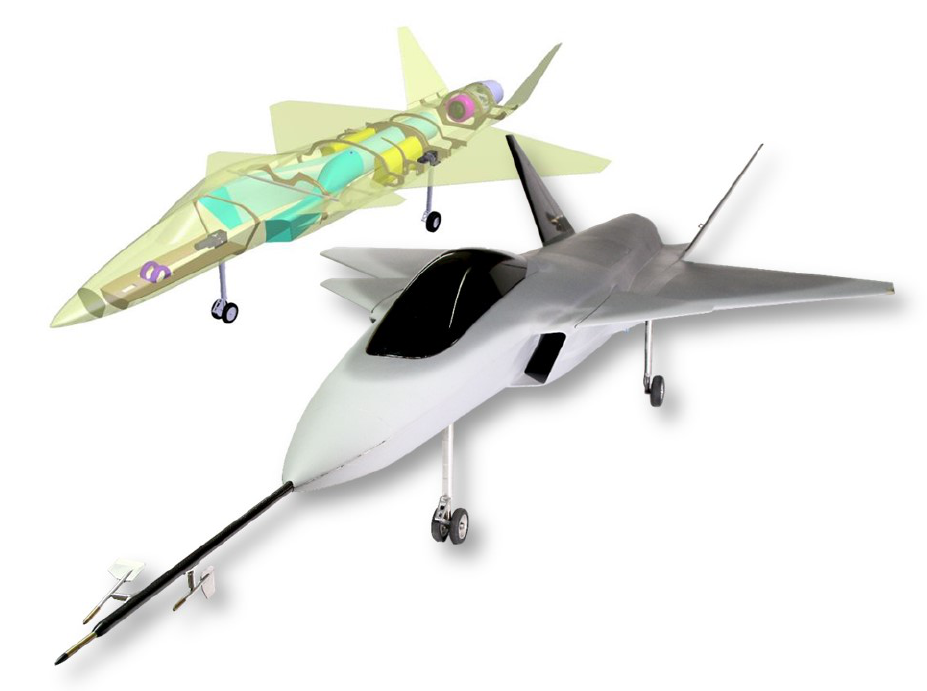
Figure 10. Overview of the GFF subscale